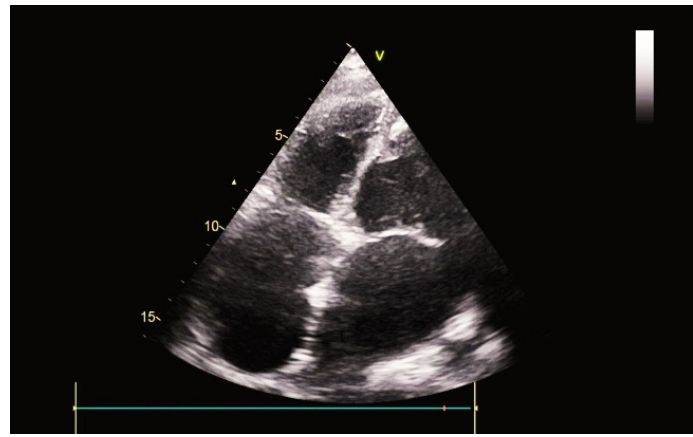
Figure 4. Ultrasound image after tRVAD explantation . Renal replacement therapy was used to optimize the circulatory status. Macytentan (1 × 10 mg) and iloprost (6 × 20 mg) were introduced. Meanwhile, severe edema of the lower right extremity evolved into deep venous ulceration and required specialized care.